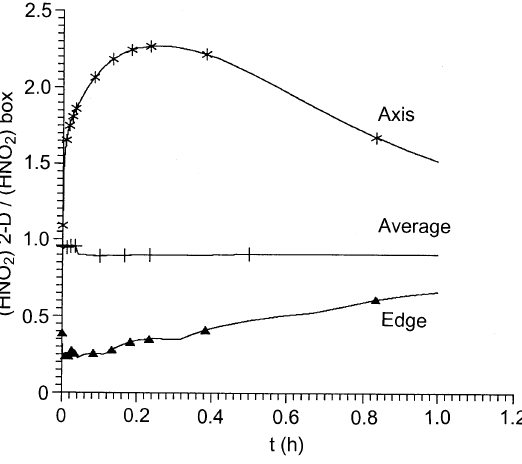
Fig. 2. Time evolution of the HNO (cid:50) mixing ratio: at the Gaussain plume axis ; at this plume edge ; and integrated over the plume cross section area ( average ) — relative to the HNO (cid:50) mixing ratio in the box model for the same basic